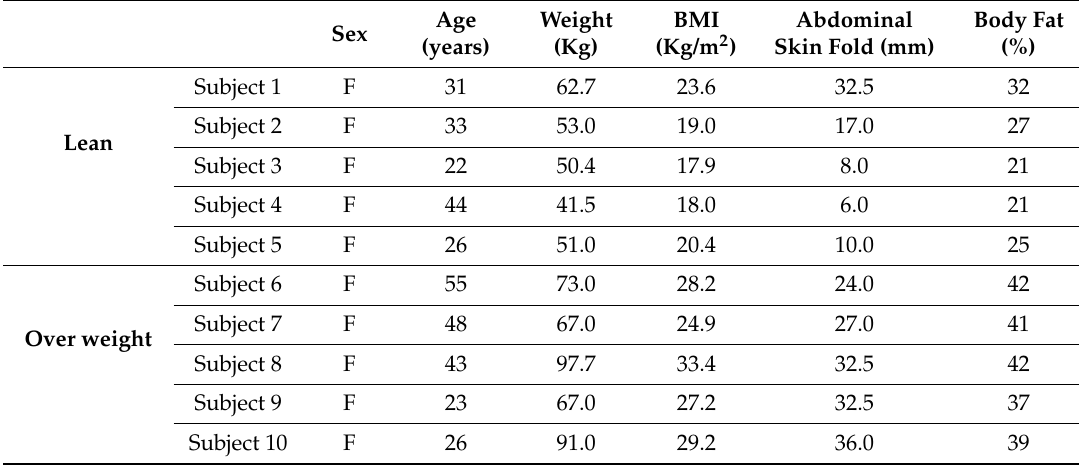
Table 1. Participant